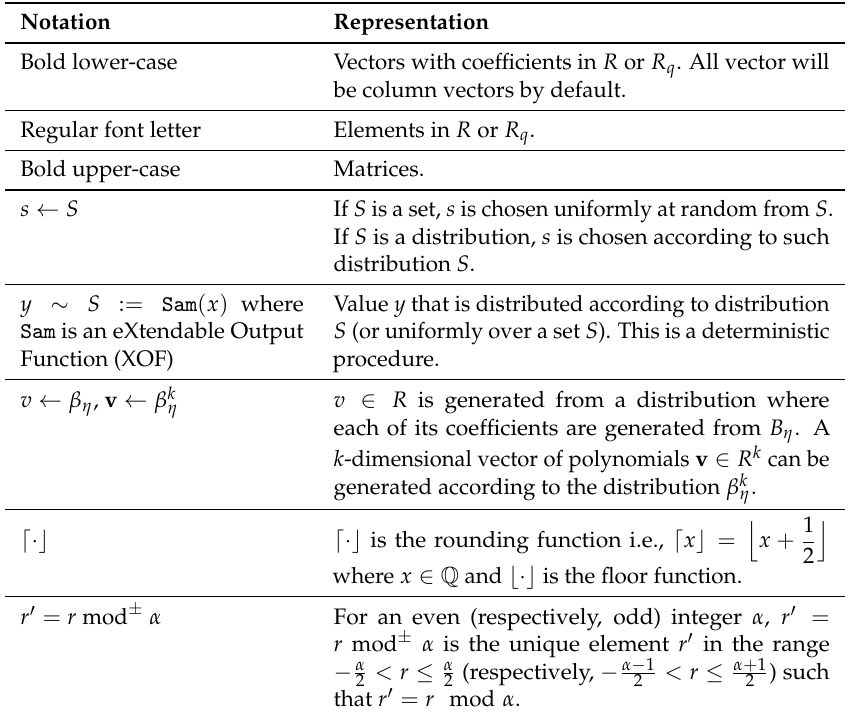
Table 3. Notation used for Kyber.CPA (cid:48)